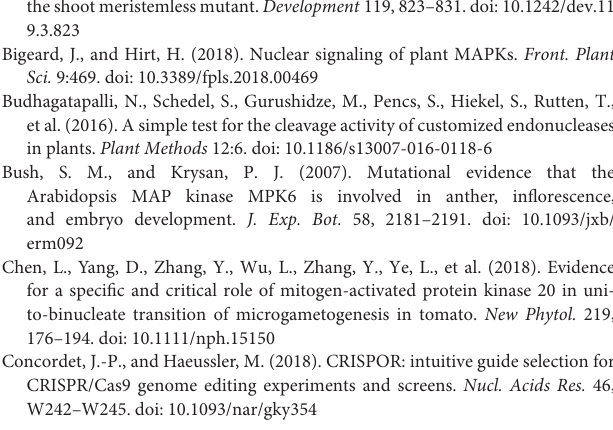
Supplementary Table 1 | Overview of oligonucleotides used in this study. Supplementary Table 2 | BLASTP: Specificity of the “REALAFNPEYQQ” epitope toward HvMPK6. Supplementary Table 3 | Overview of the off-targets predicted by CRISPOR. Supplementary Figure 1 | The transcribed portion of the genomic sequence of the HvMPK6 gene.